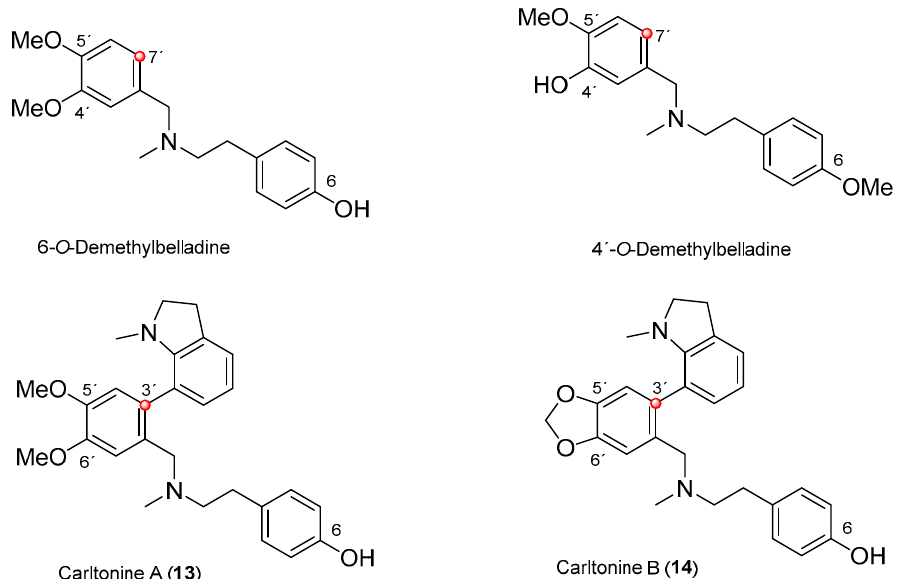
Figure 3 . Structures of newly isolated ( 13 and 14 ) and recently reported belladine-type AAs 6- O - 6- O -demethylbelladine and 4 (cid:48) - O -demethylbelladine demethylbelladine and 4´- O -demethylbelladine [37].